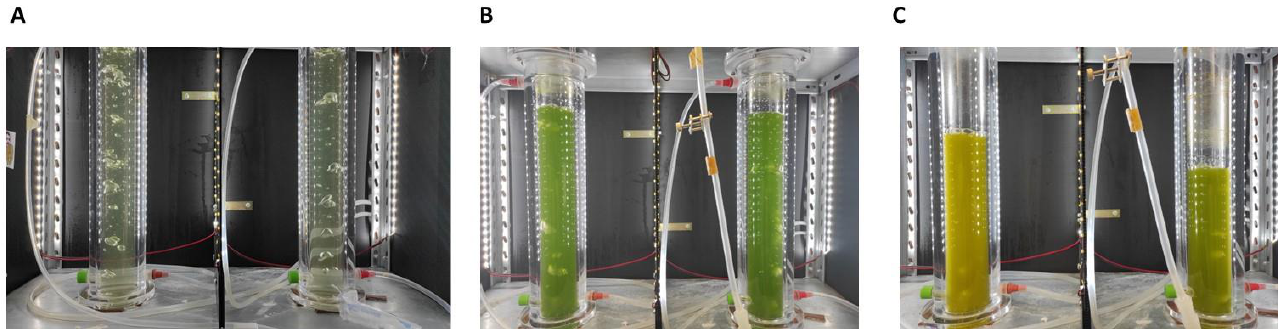
Figure 3. Images of Neocloris oleoabundans #1185 cultivation in air-lifts bioreactors at day 0 ( A ), 5 ( B ) and 15 ( C ) of fermentation.